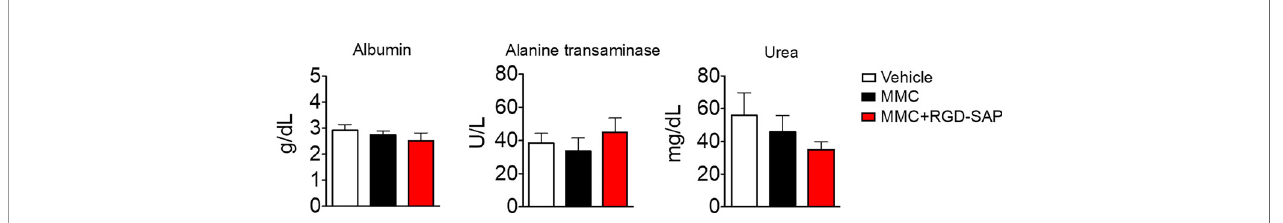
FIGURE 8 | Comparison of clinical biochemistry parameters in mice treated with mitomycin C (MMC) alone or in combination with RGD-SAP. Blood samples were collected from treated mice and the concentration of albumin, alanine transaminase and urea in the serum were measured. Values are shown as mean ± SD from n = 10 for vehicle and MMC; n=5 for MMC +